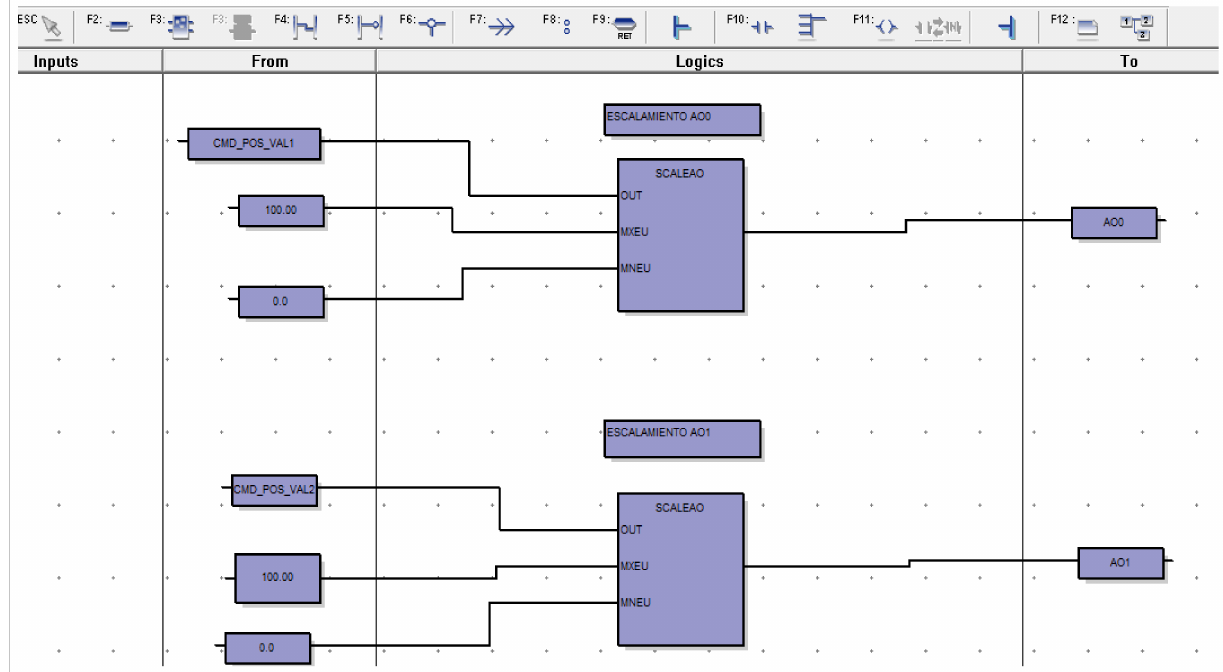
Figure 9. Main program, analog output signals.